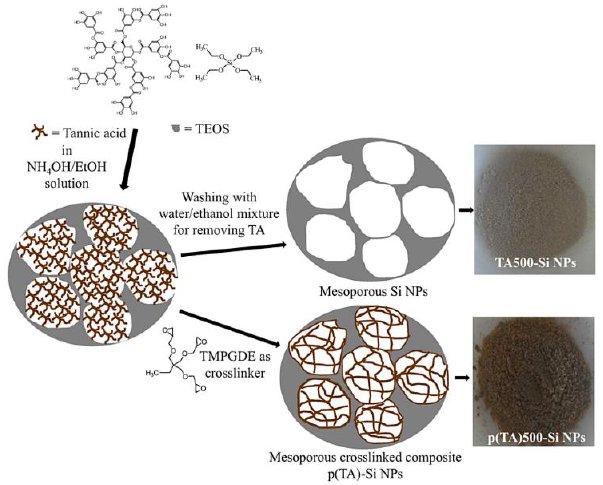
Figure 16. Schematic representation of an effective hybrid monodispersed nanoantioxidant p(TA)-Si NPs composite of tannic acid and silica nanoparticles via a modified Stöber method and one-pot synthesis. Reprinted (adapted) with permission from [27].